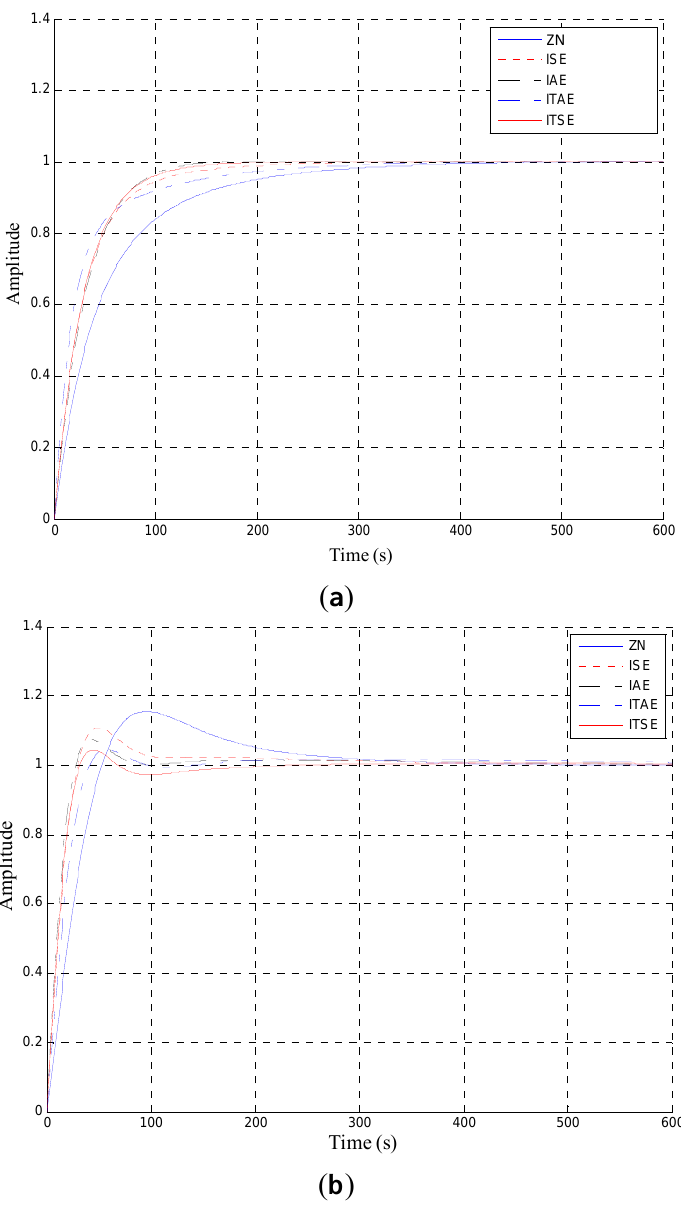
Figure 7. Output responses corresponding to different PID tuning methods. ( a ) Response curves of output 1; ( b ) Response curves of output